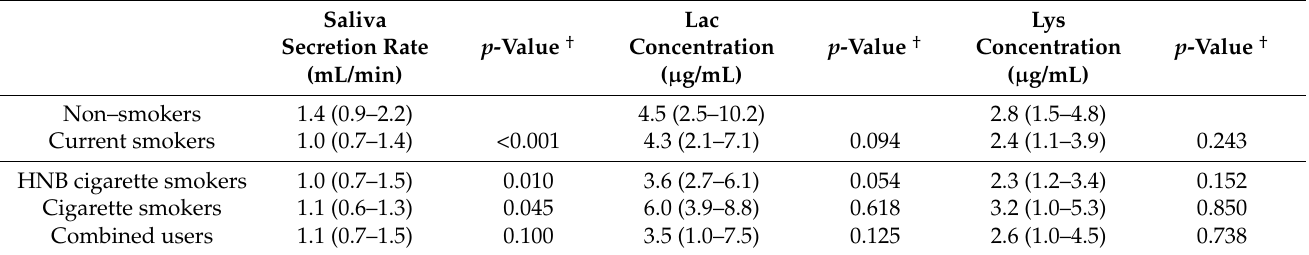
Table 2. Saliva secretion rates and concentrations of Lac and Lys.